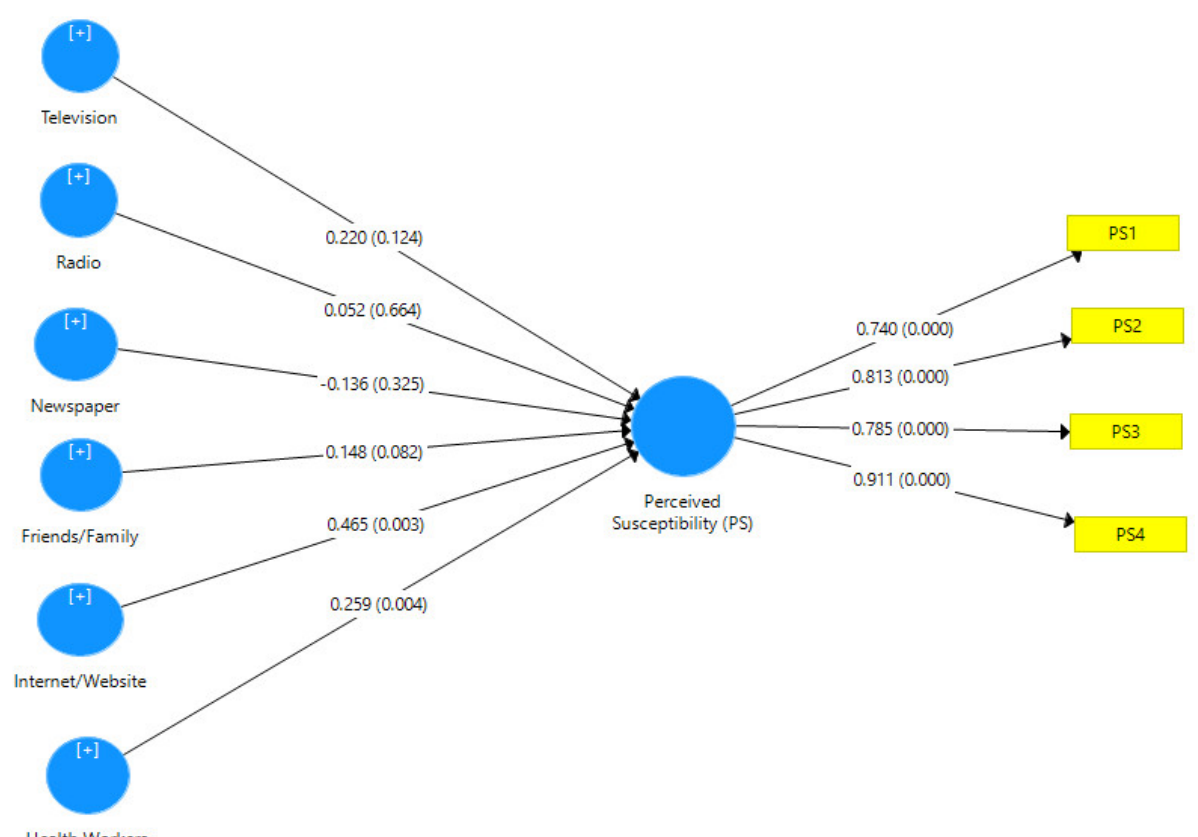
Figure 1. Information sources and women’s perceived susceptibility to breast cancer model.